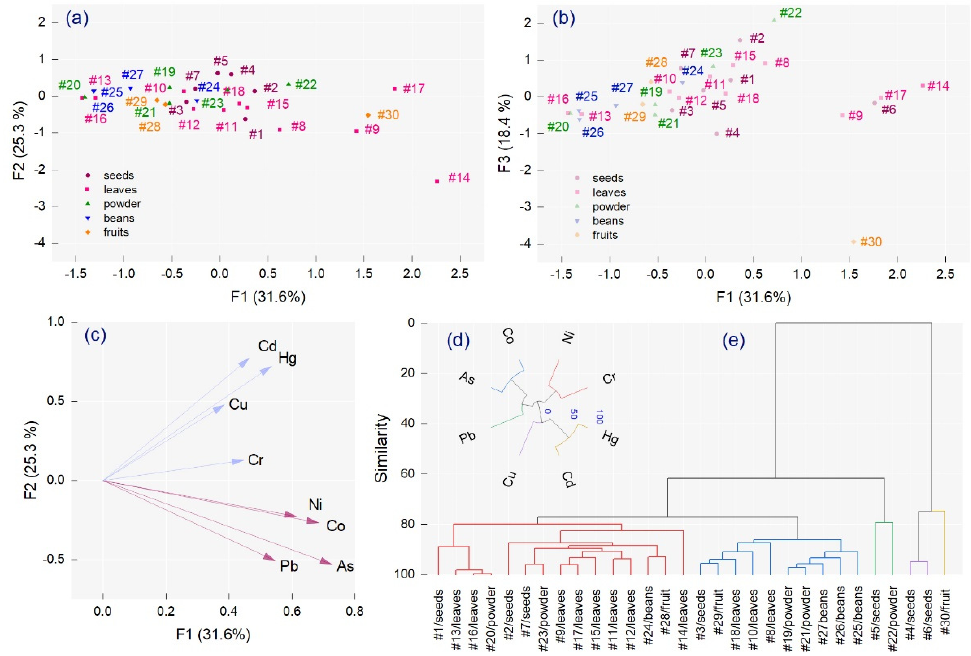
Figure 3. 2D score plots for the 30 spices investigated from the Romanian market, ( a ) factor analysis (F1 versus F2), ( b ) factor analysis (F1 versus F3), ( c ) factor analysis loading plot by PCA extraction, analysis (F1 versus F3), ( c ) factor analysis loading plot by PCA extraction, ( d ) hierarchical cluster dendrogram for metals, ( d ) hierarchical cluster dendrogram for metals, and ( e ) hierarchical cluster dendrogram for samples. and ( e ) hierarchical cluster dendrogram for